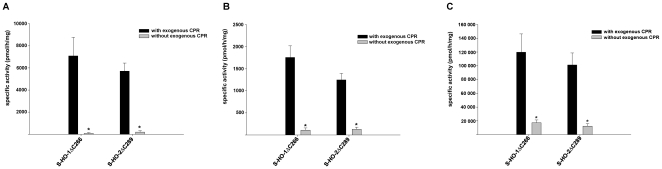
Comparison of enzyme activity of the carboxy-terminally deleted HO isoforms.Measurements were made in the presence (black columns) and absence (grey columns) of exogenous CPR. (A) Activity measured in the cytosolic fractions from Sf9 cells expressing the HO mutants. (B) Measurement in homogenates from infected Sf9 cells. (C) Enzyme activity assay after purification using the Strep-tag/Streptavidin system. Data are shown as means ± SEM (n = 3, *p<0.05).